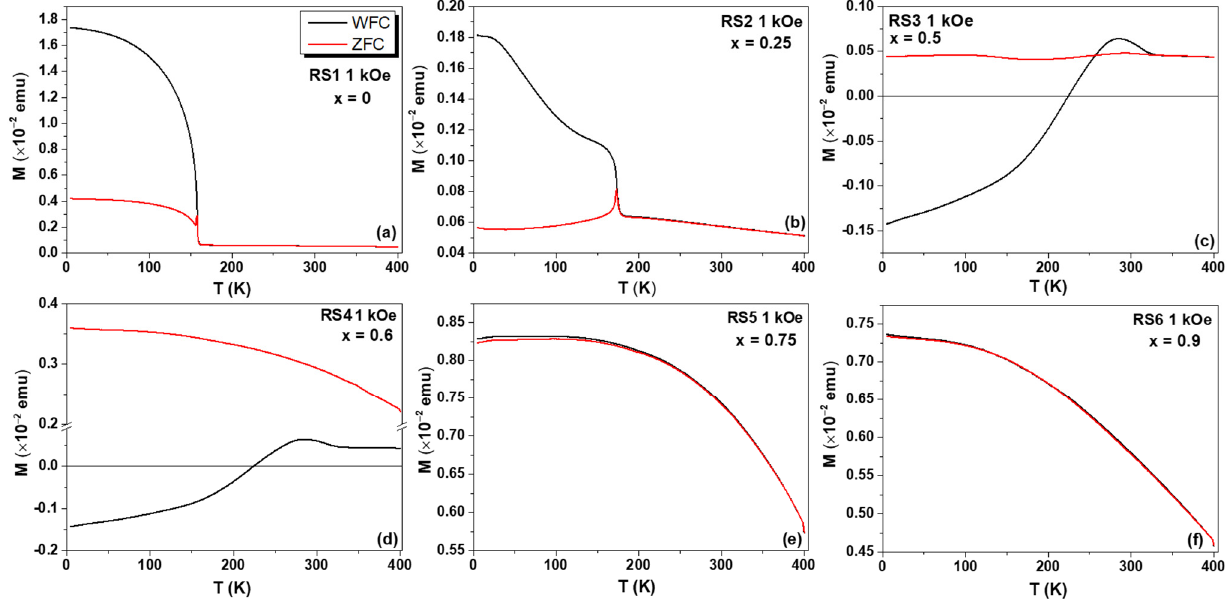
Figure 10. ZFC and WFC M(T) curves recorded at a probe field of 1000 Oe for the ( a ) RS1, ( b ) RS2, ( c ) RS3, ( d ) RS4, ( e ) RS5, and ( f ) RS6 samples.